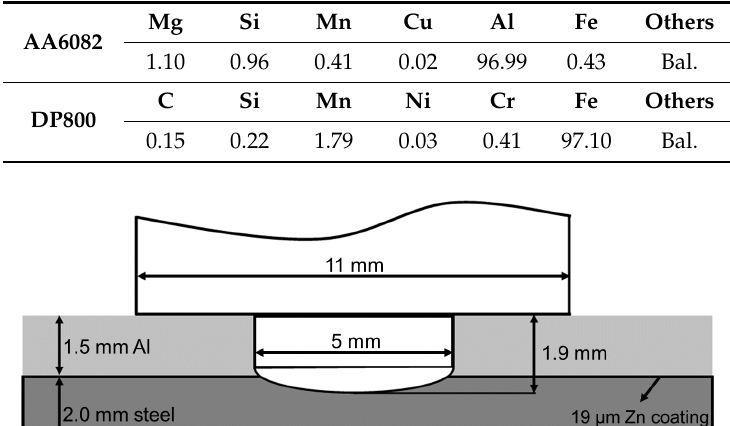
Table 1. Nominal chemical compositions of base materials (wt. %).